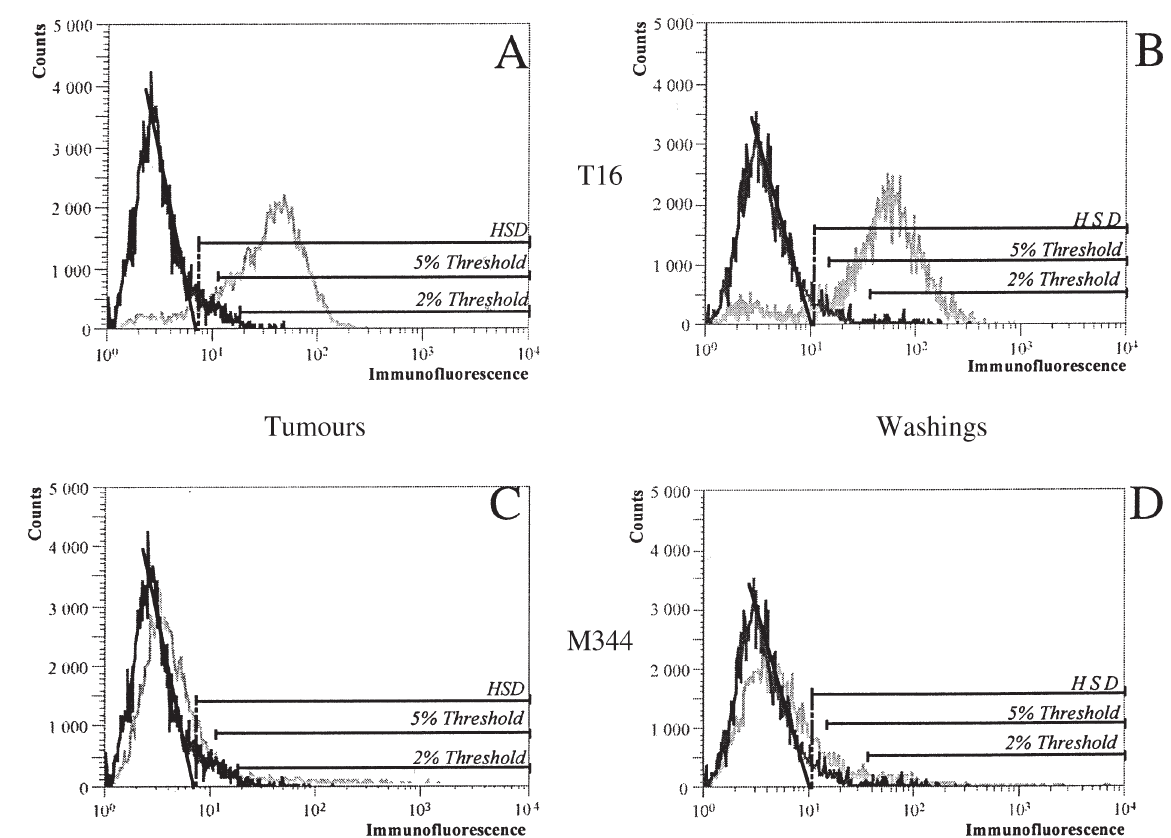
Fig. 1. Threshold settings from blank histograms. The immunofluorescence of control cells is represented in black histograms and that of sample cells in grey histograms, for T16 antigen expression (A and B) and M344 antigen expression (C and D), in either tumour cells (A and C) or cells from bladder washings (B and D). The settings of the threshold used to determine the number of positive cells in sample histograms is indicated by the horizontal bars in each histogram and was determined from the corresponding control histogram (HSD stands for Histogram Shape Dependent